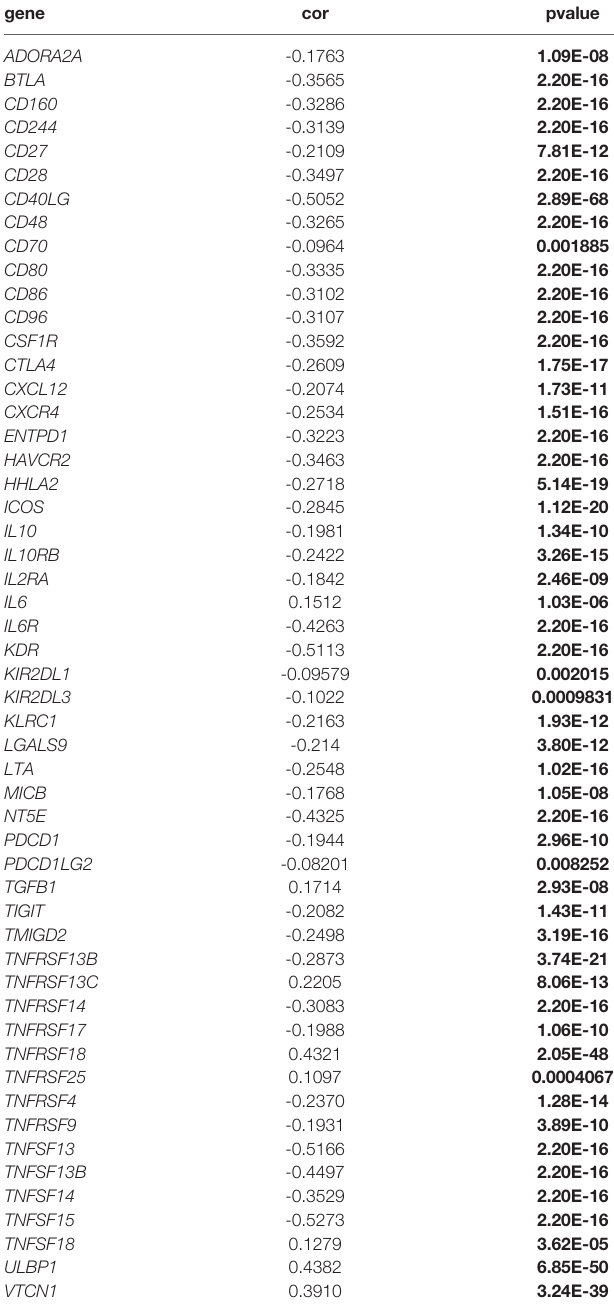
TABLE 5 | Correlation analysis of SLC6A8 expression with immunomodulators. gene